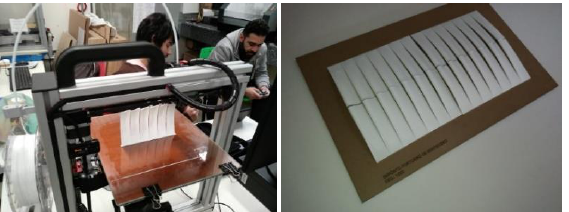
Figure 12: 3d printing process and assembling of the complete whole roof surface on a mdf base.